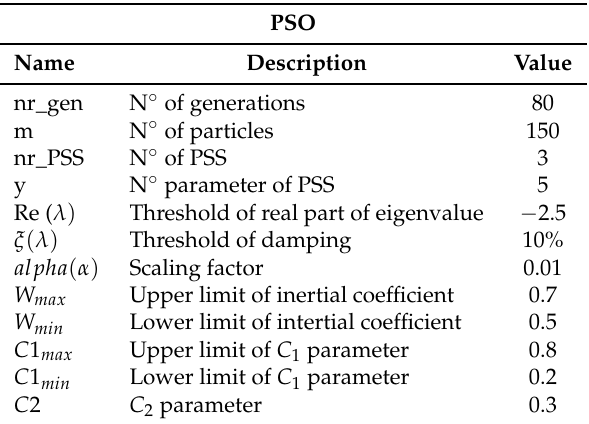
Table 1. Variables of PSO 3 for system I.